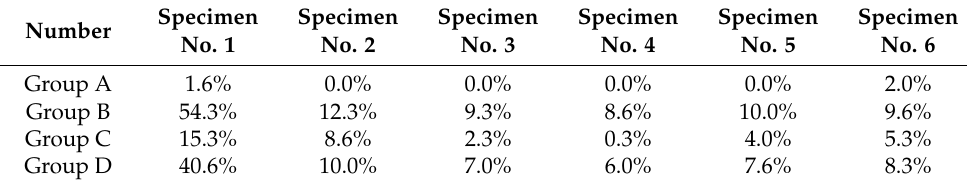
Table 13. The measured value of adhesion of paint film for